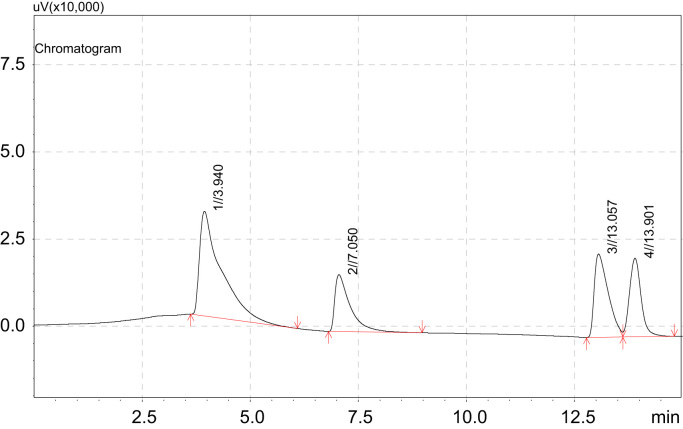
Sample standard.